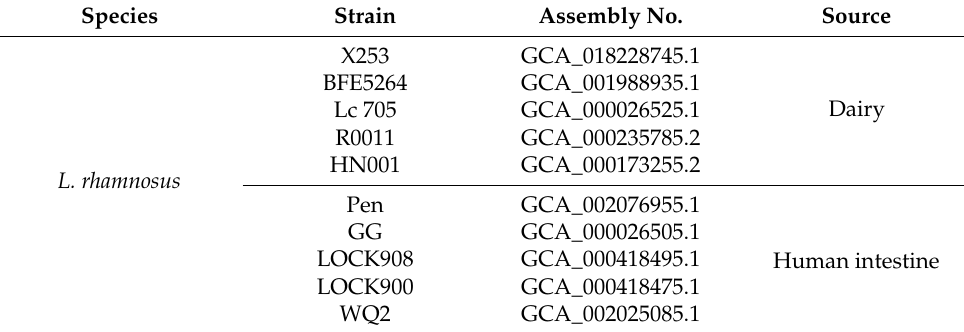
Table 1. L. rhamnosus strains used in this